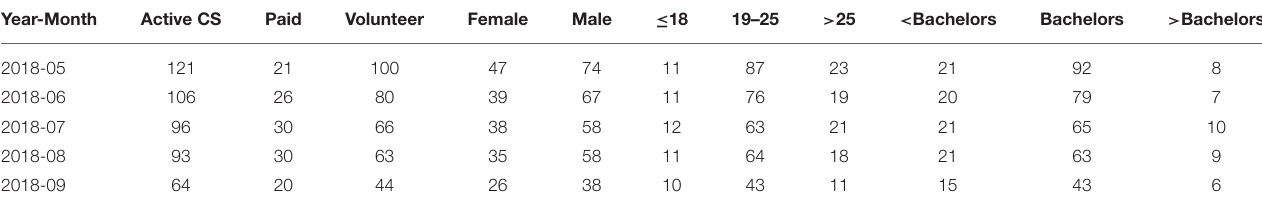
TABLE 2 | Number and compositions of citizen scientists taking measurements from May through September